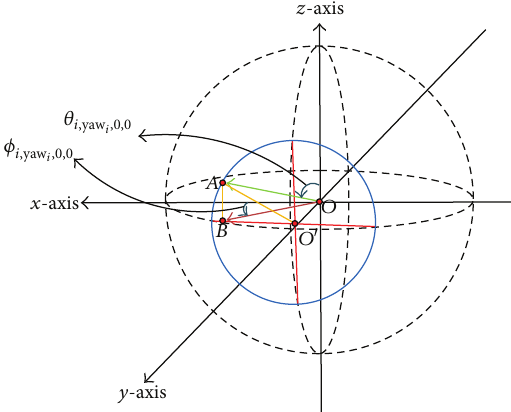
Figure 6: Effect of platform pitch angle to the antenna